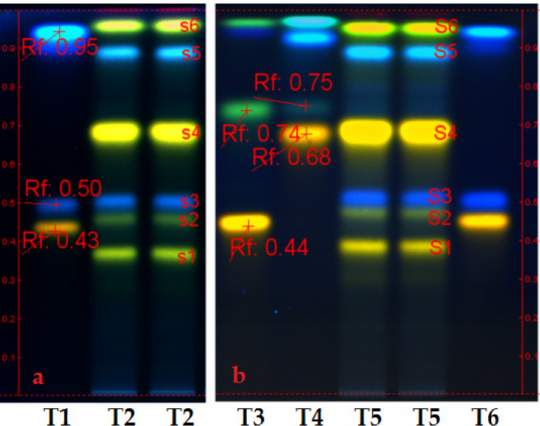
Figure 1. (Chromatograms a and b ). Polyphenols profile in Stokesia laevis L. ethanolic extracts. Where: Chromatogram a). Track T1, rutin, chlorogenic acid, and caffeic acid (ref.). Tracks T2–whole (70%) ethanolic extract from Stokesia laevis (Slae)-duplicate sample; Chromatogram b). Track T3, rutin, vitexin, protocatechuic acid, and apigenin (ref.); Track T4, hyperoside, cosmosiin, rosmarinic acid, and kaempferol; Tracks T5–standardized (40%) ethanolic extract from Stokesia laevis (Slae26)-duplicate sample; Track T6, rutin, chlorogenic acid, and caffeic acid